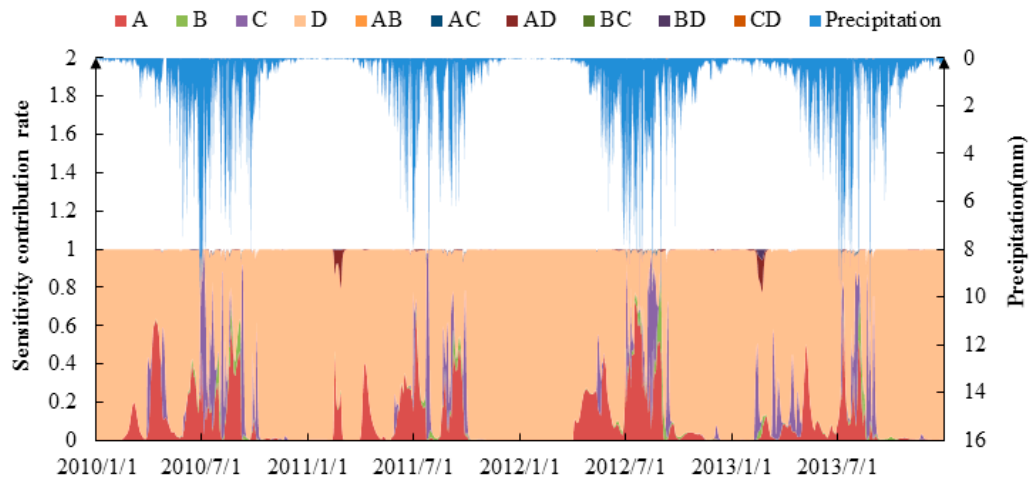
Figure 5. Dynamic characteristics of the parameter sensitivity contribution.